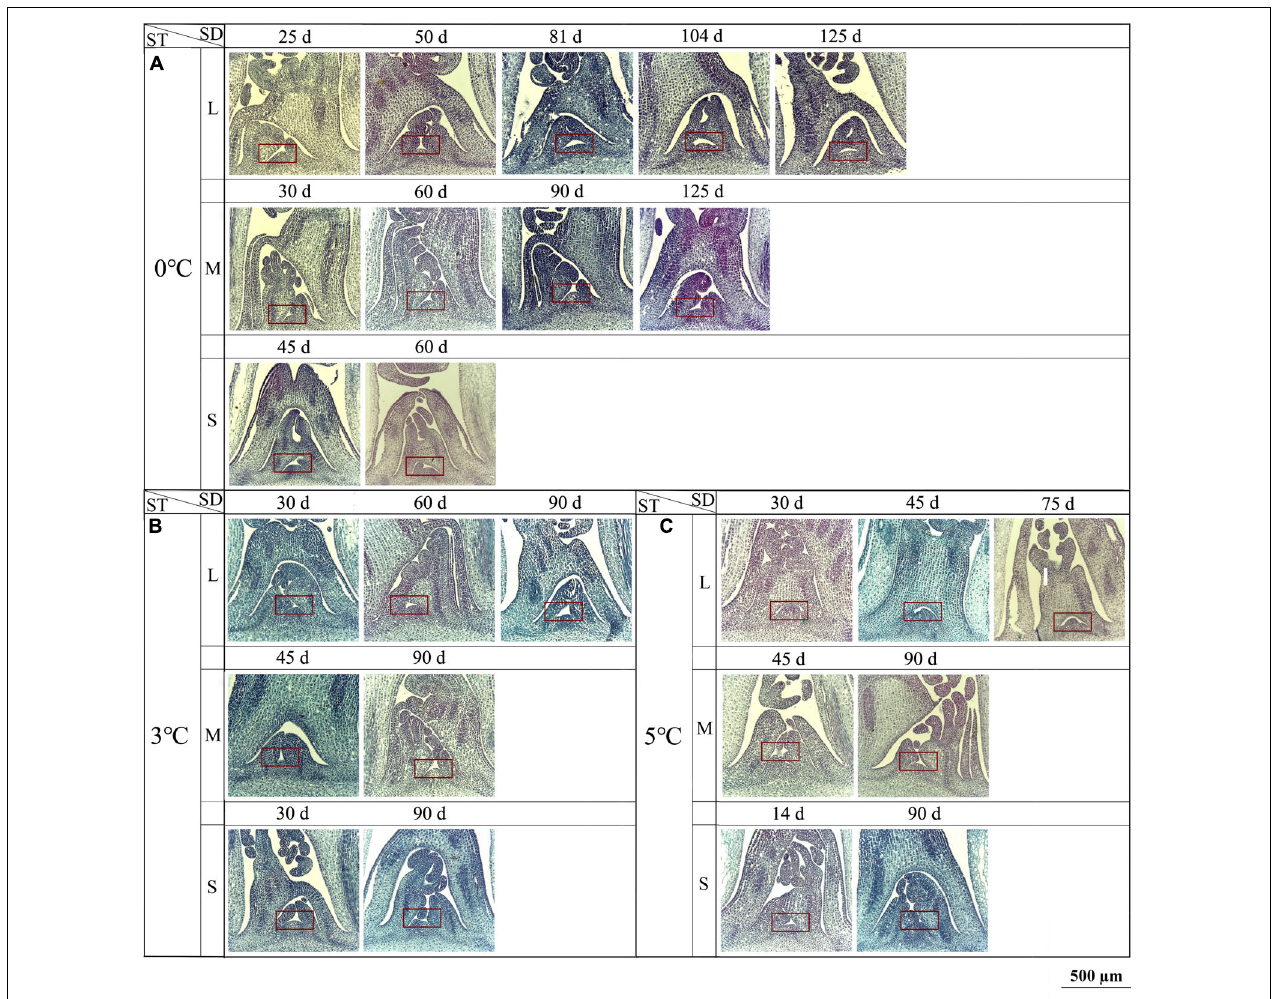
FIGURE 6 | Changes in longitudinal anatomical structure (10 × magnification) of the SAM seedlings of Angelica sinensis at different storage temperatures and durations. The red frame shows the SAM. Panels (A–C) represent the structure of the SAM at 0, 3, and 5 ◦ C, respectively. SD, storage duration; ST, storage temperature; L, large size; M, medium size; S, small size. n = 10 per stage for the different size